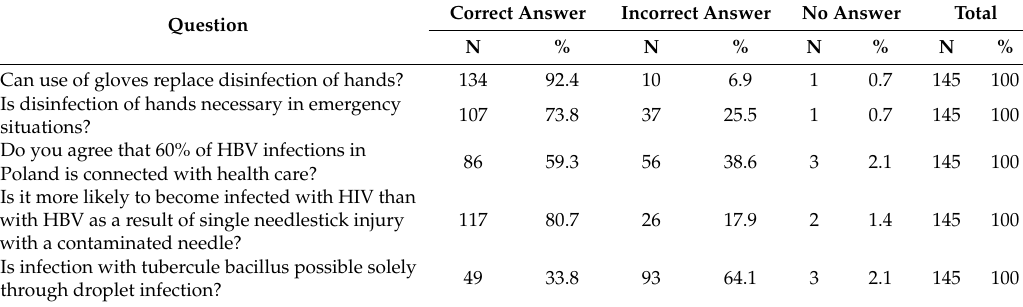
Table 3. Distribution of the responses provided by the paramedics during the test of